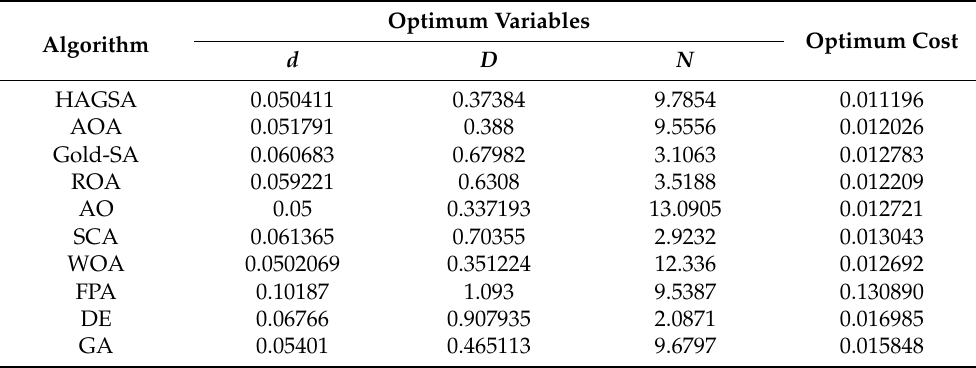
best cost of this design problem is 0.011196, and the three parameters are 0.050411, 0.37384,